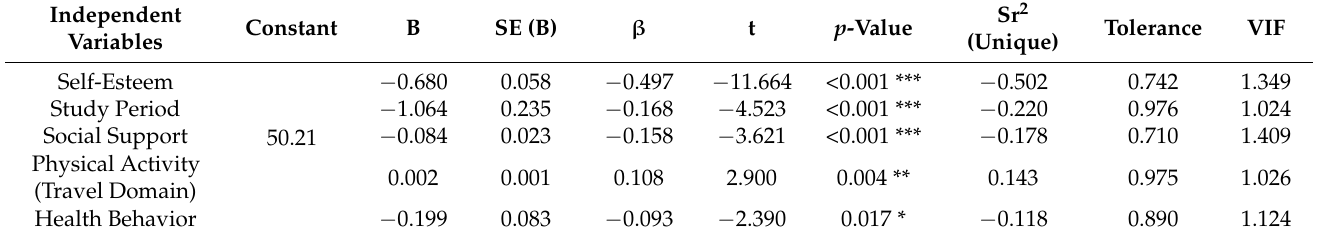
Table 4. Stepwise multiple regression of the relationship of self-esteem, study period, social support, physical activity in the travel domain, and health behavior with the stress level of Thailand university students during